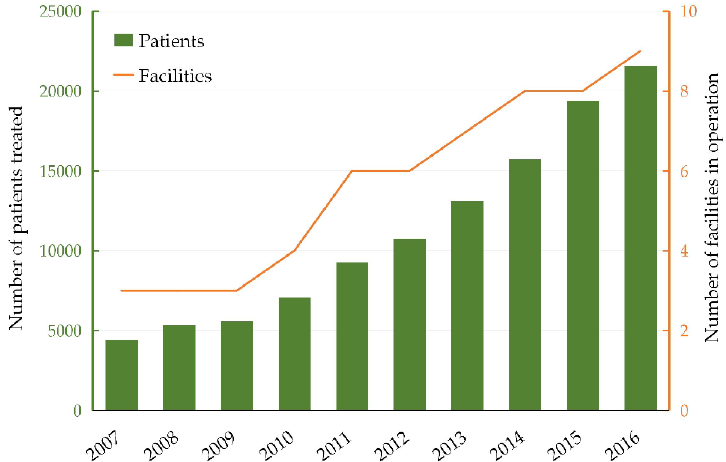
Figure 1. The number of patients treated by C-ion radiotherapy and the number of facilities in operation during the past 10 years (2007–2016).